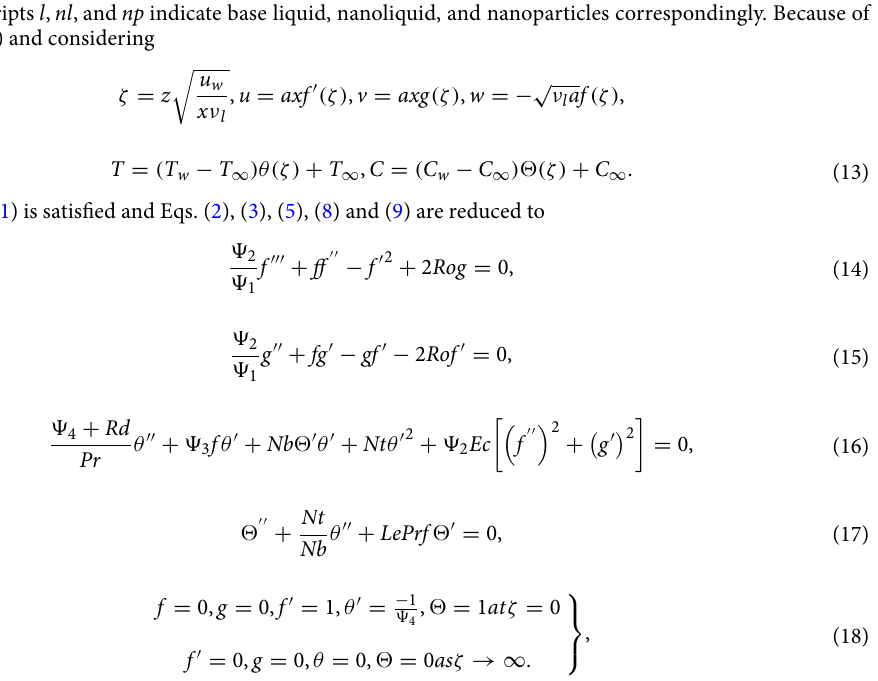
where ζ -similarity variable, f , g , θ , and (cid:31) are dimensionless axial velocity, transverse velocity, temperature, and nanoparticle volume fraction correspondingly, prime denotes the differentiation with respect to ζ , Pr (Prandtl number), Ro parameter), Ec